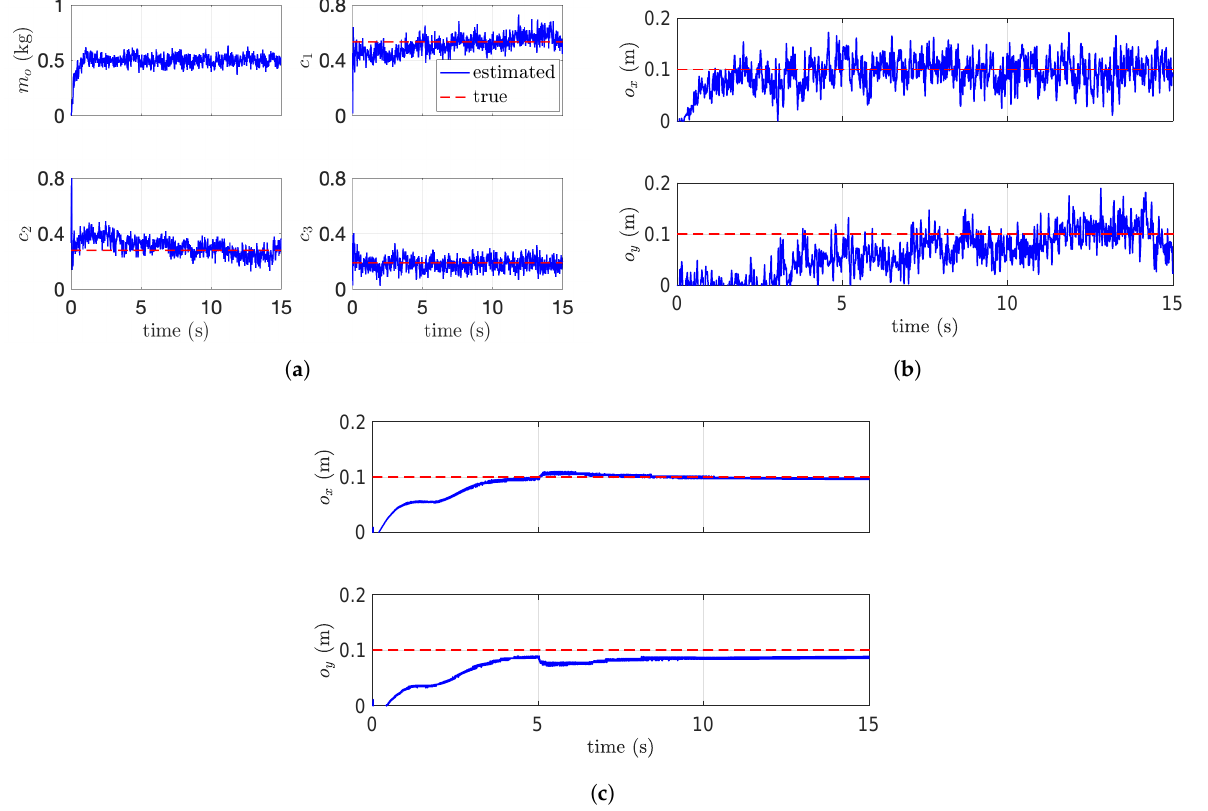
Figure 9. Estimation performance of three aerial manipulators. ( a ) Dynamic parameter estimation. ( b ) Estimation of o x and o y . ( c ) Estimation of o x and o y without